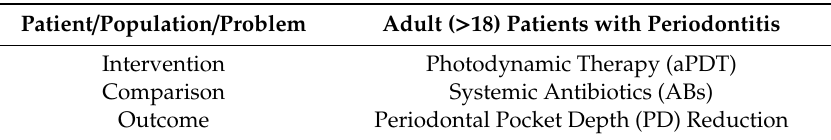
Table 1. The PICO (Participants / Interventions / Comparisons / Outcomes)